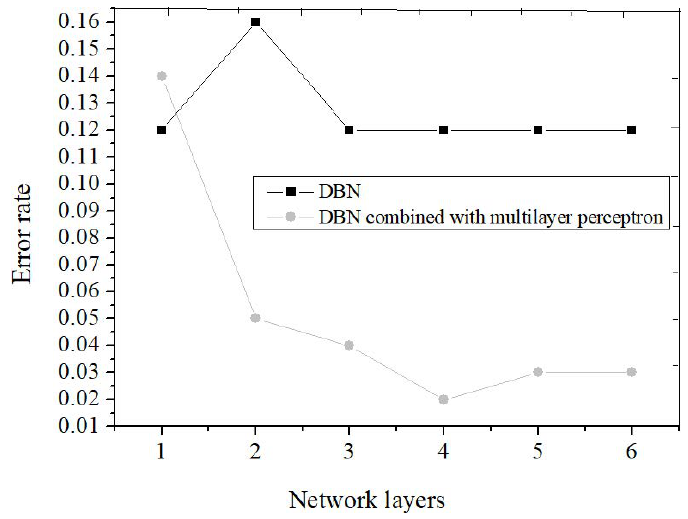
Fig. 7 Relationship between model error rate and number of network layers. DBN: deep belief